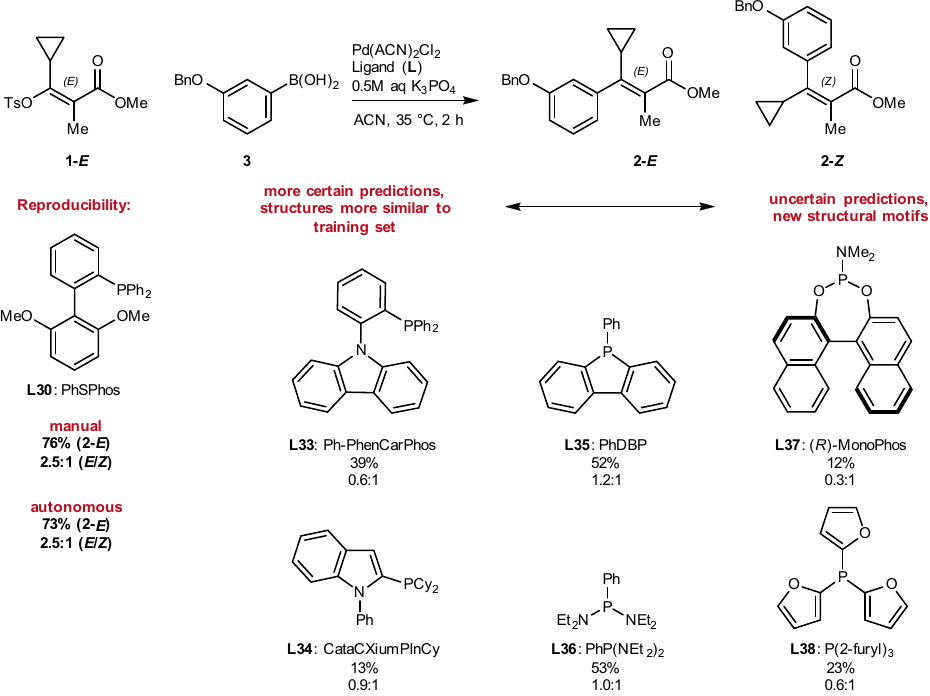
Fig. 10 Manual experiments under optimized conditions with predicted E -selective ligands. Conditions: 10 µ mol 1- E , 1 µ mol 1,3,5-trimethoxybenzene, 15 µ mol (3-(benzyloxy)phenyl)boronic acid 3, 0.4 µ mol Pd(ACN) 2 Cl 2 , 0.9 µ mol L, 30 µ mol K 3 PO 4 (0.5 M aq) in ACN (0.05 M), 2 h at 35 °C. Comparisons of the predicted and experimental yields are provided in Supplementary Information Table